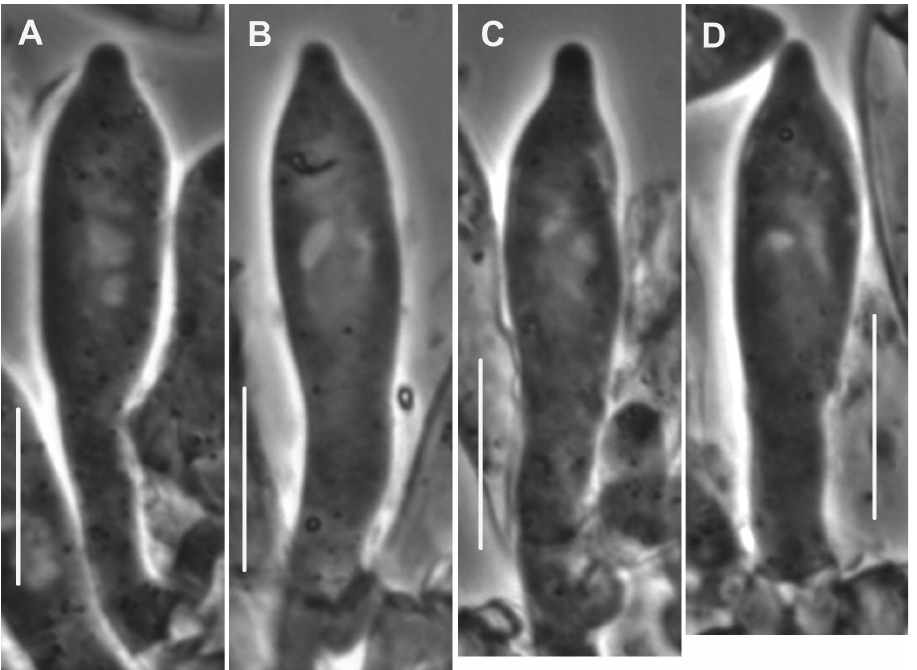
Figure 54. Mycetinis opacus . Pleurocystidia. Note submammilate apices. Standard bars = 10 µm. TFB 14629